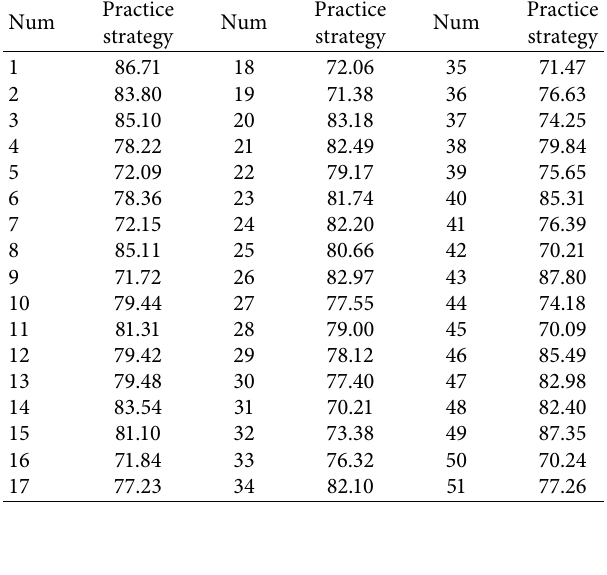
Table 1: Verification of the effect of practical strategy formulation of school labor education in the information environment.